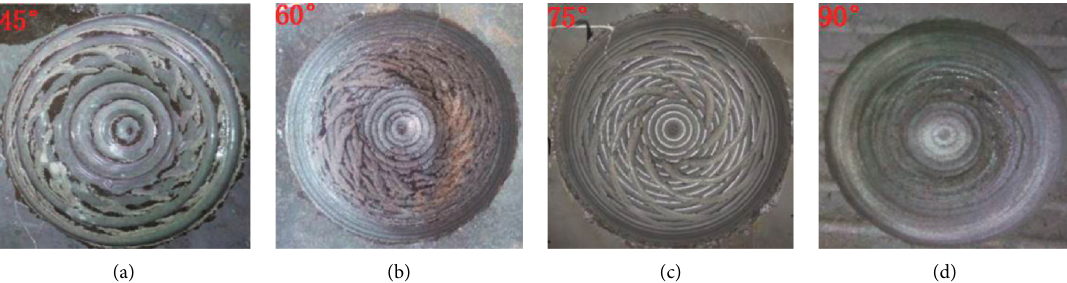
Figure 21: Bottom-hole generated by the novel bit under different deviation angles. (a) 45 ° , (b) 60 ° , (c) 75 ° , (d) 90 ° .